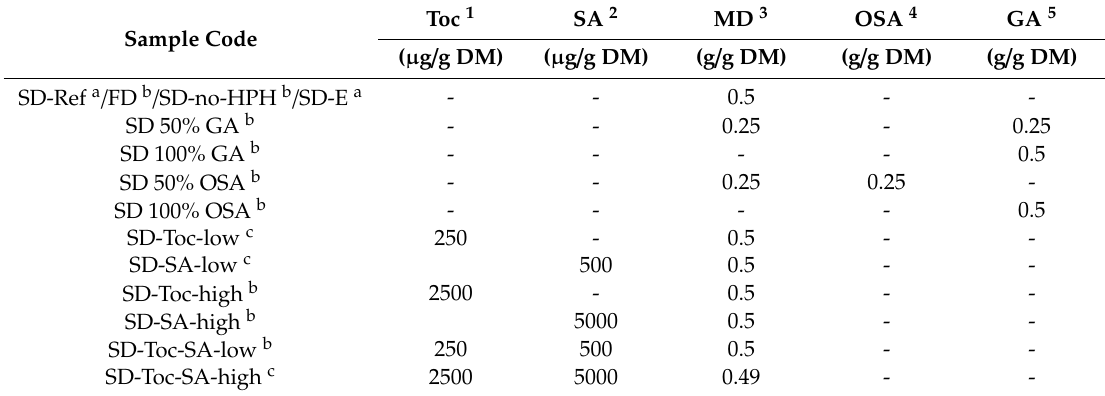
Table 1. Concentration of tested recipe components in the produced carrot concentrate powders. Residue dry matter (DM) consists of carrot concentrate